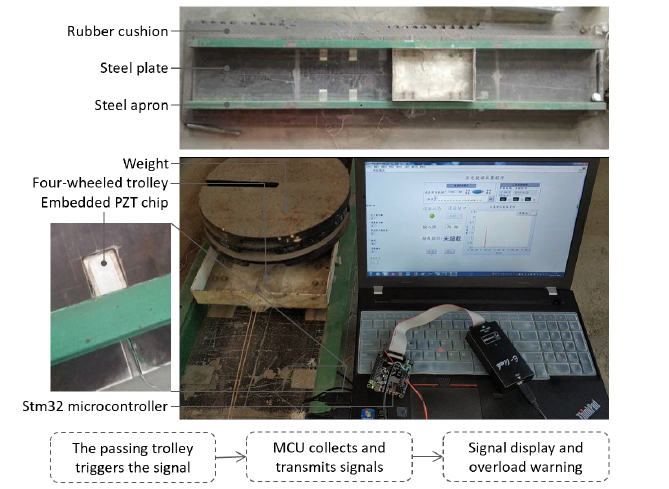
Figure 2. The moving load identified